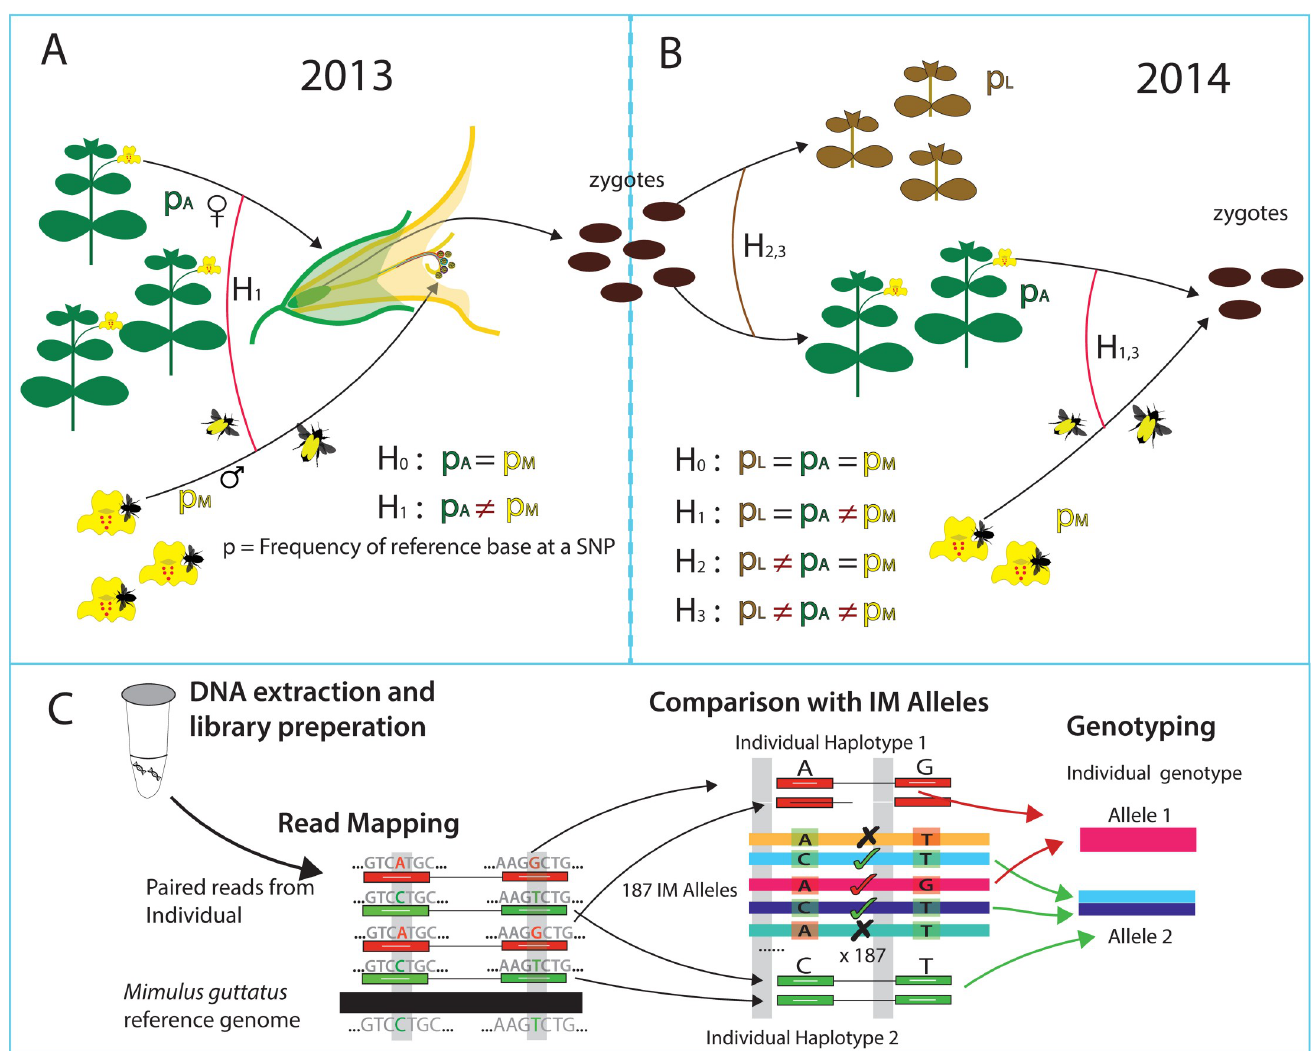
Fig 1. The parameters of alternative selection models are depicted for the (A) 2013 and (B) 2014 data. Hypothesis tests are expressed in terms of parameter constraints where p indicates reference base frequency: p A for reproductive adults, p M for successful male gametes, and p L plants for plants that fail to reproduce. H 0 is the full neutral model. Male selection is tested by contrast of H 1 to H 0 in 2013 and H 3 to H 1 in 2014. Viability selection is tested by contrast of H 3 to H 2 . (C) After DNA sequencing, read-pairs are mapped to the M . guttatus reference genome. The haplotype matching method (read-pairs to genic-haplotypes) is illustrated for a simple case with read-pairs mapping to single location. Read-pairs impose a probabilistic ‘process of elimination’ on reference line sequences as putative ancestors: p indicates consistency and “X” inconsistency.